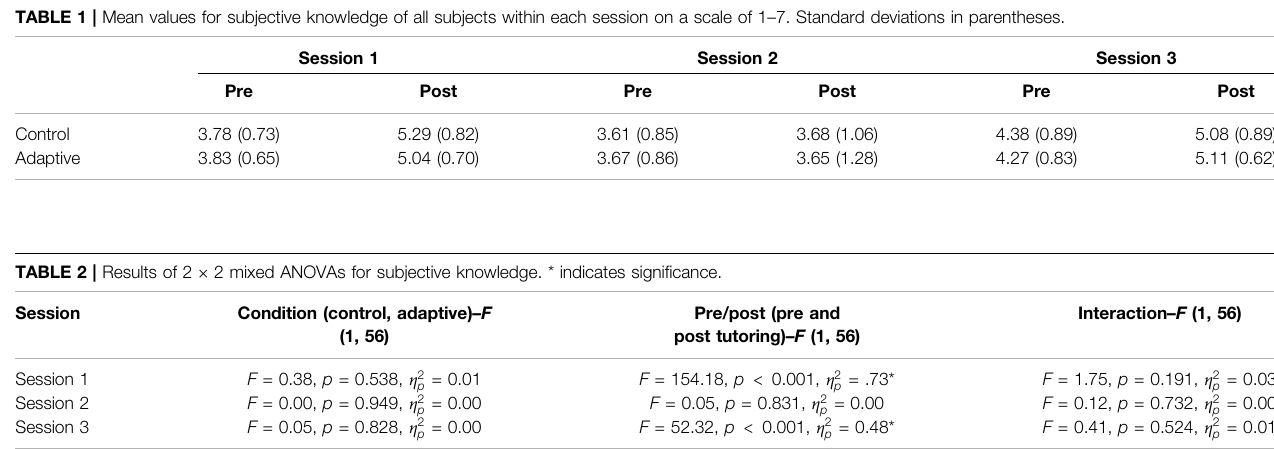
TABLE 1 | Mean values for subjective knowledge of all subjects within each session on a scale of 1 – 7. Standard deviations in parentheses.